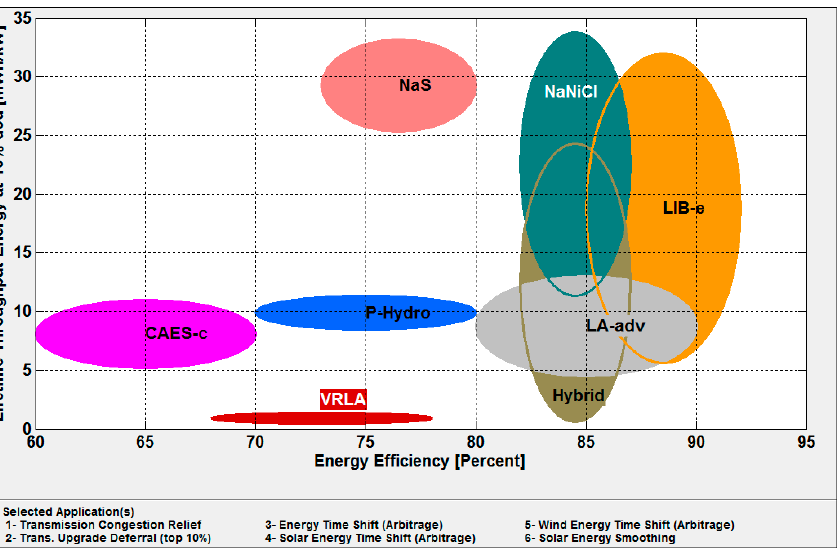
Figure 10. Lifetime throughput Energy at 10% dod (MWh/kW) as a function of energy efficiency (%) for different ESS.